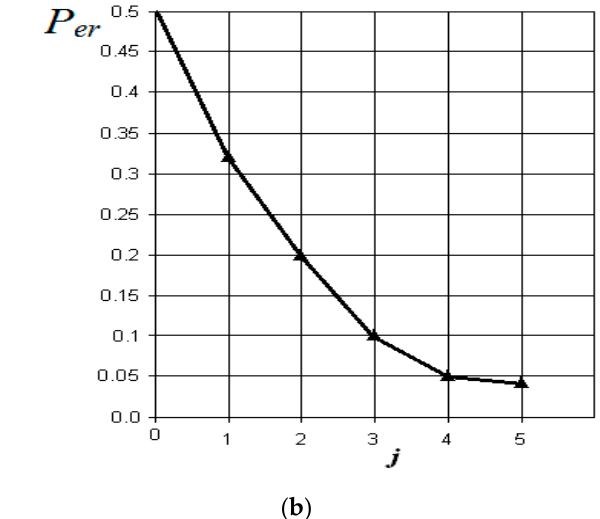
Figure 8. Results of discriminant analysis of data when comparing the norm with chronic odontogenic sinusitis: ( a ) dependence of the increase in the normalized Euclidean distance as signs are added to the discrimination model F(j)   ; ( b ) ‐ the dependence of the decrease in the probability of error in decision ‐ making as features are added to the discrimination model